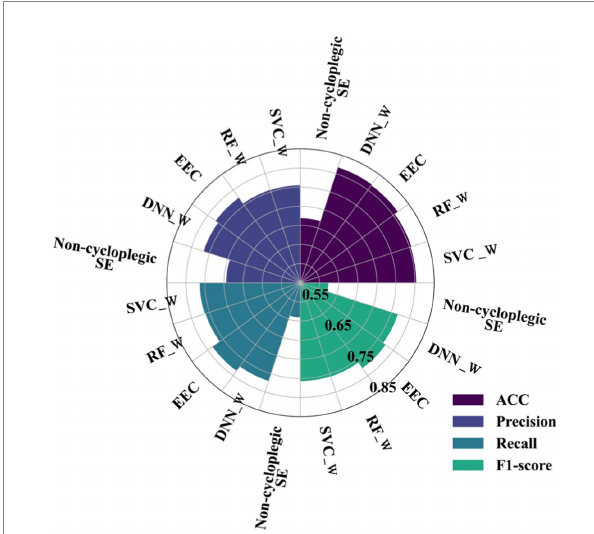
FIGURE 3 Performances of four machine learning algorithms and directly using non-cycloplegic SE for three- class classification. (SVC_W, Support Vector Machine with balance method; RF_W, Random Forest with balance method; DNN_W, Deep Neural Network with balance method; EEC, Easy Ensemble Classifier; ACC, accuracy; F1-score: balanced F